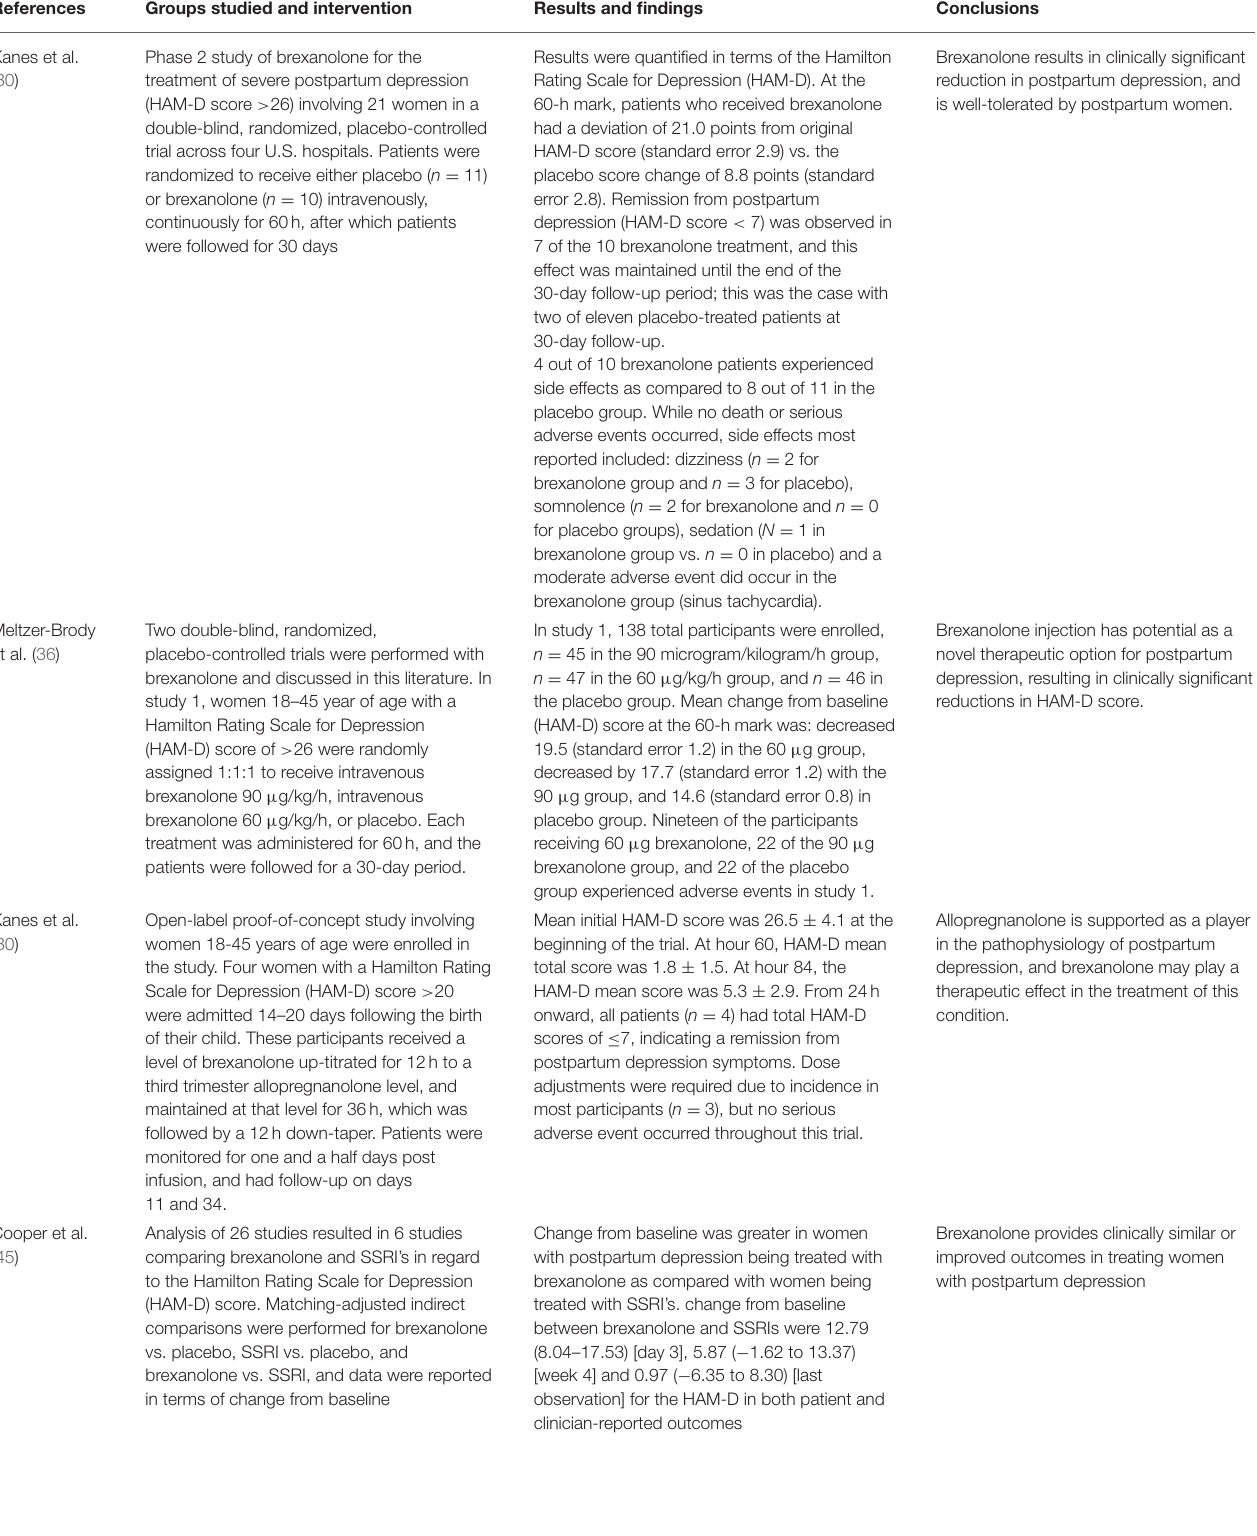
TABLE 1 | Safety and efficacy of brexanolone in treating postpartum depression in